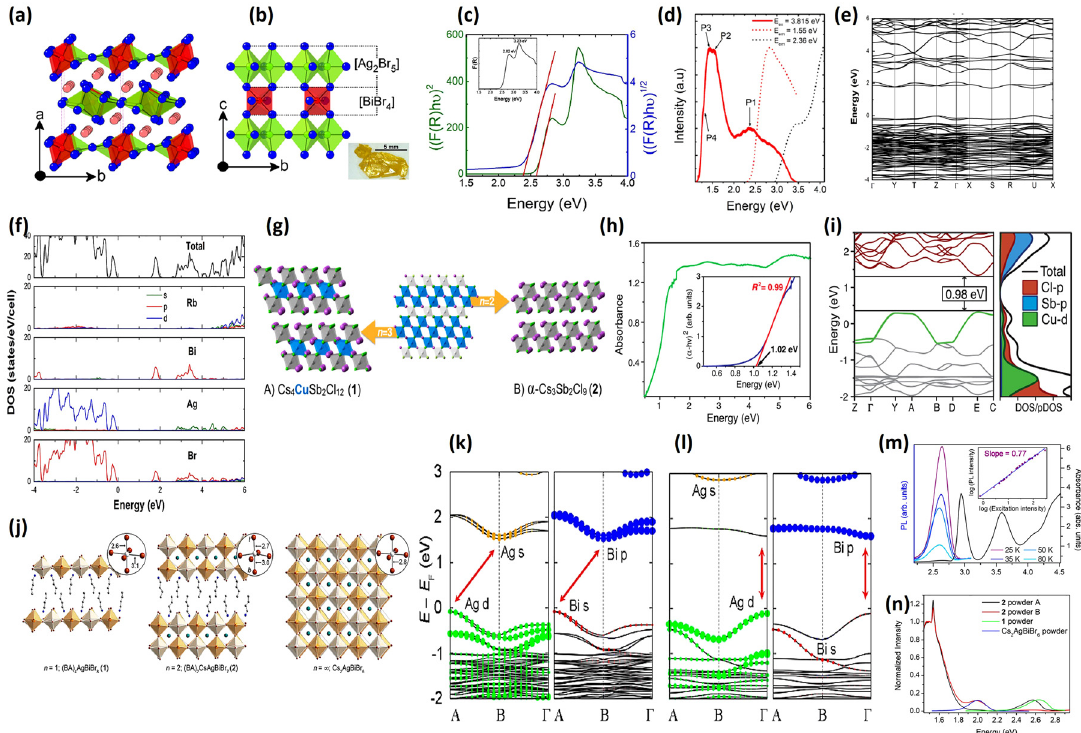
Figure 9: (a) A polyhedral representation of the crystal structure of Rb 4 Ag 2 BiBr 9 [149]. Copyright 2019, American Chemical Society. (b) A top view of a segment of a [Ag 2 BiBr 9 ] 4 − layer [149]. Copyright 2019, American Chemical Society. (c) Tauc plots of Rb 4 Ag 2 BiBr 9 . The inset: